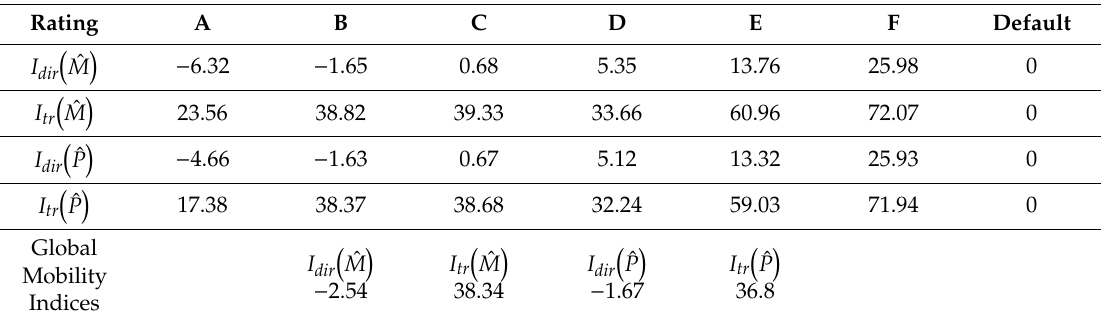
Table 9. Mobility indices by starting rating and global mobility